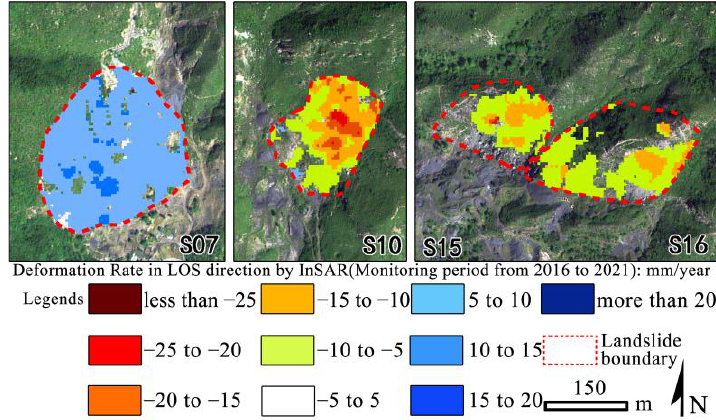
Figure 8. InSAR time series results of landslide S07, S10, S15 and S16.